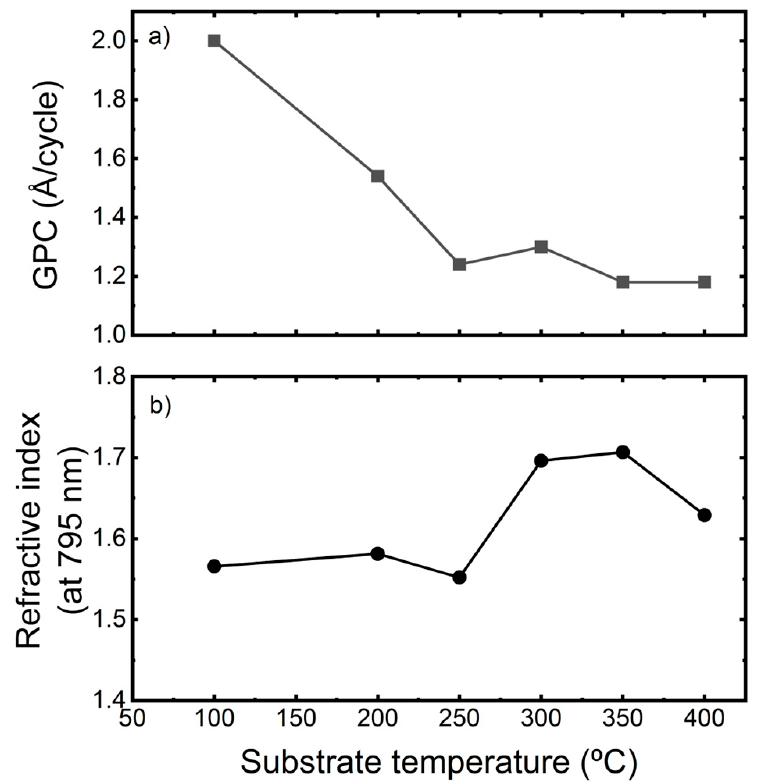
Figure 4. ( a ) ALD window; ( b ) refractive index at 795 nm of Al 2 O 3 ultra-thin films by PEALD at different temperatures.